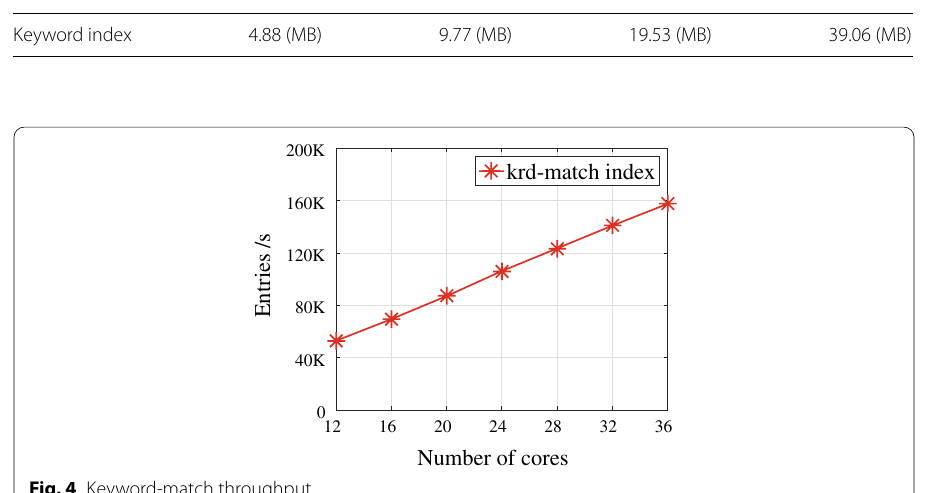
Fig. 4 Keyword-match